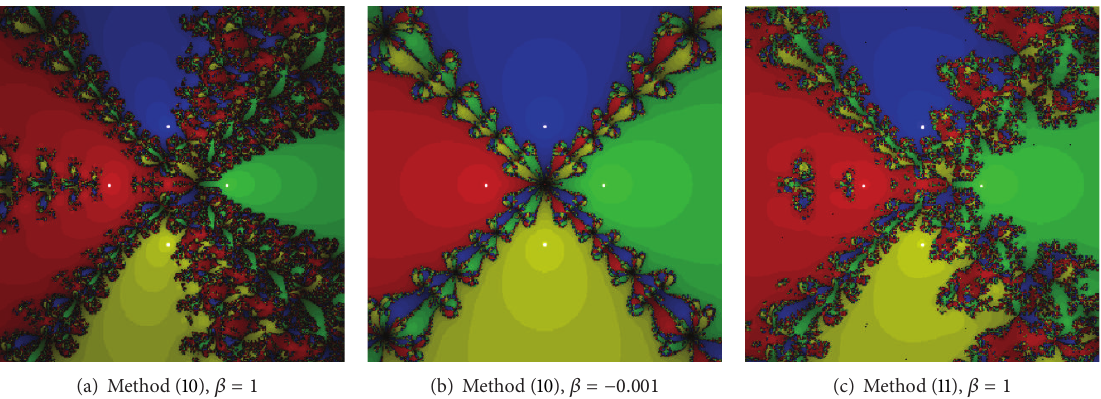
Figure 16: Basins of attraction for the test problem